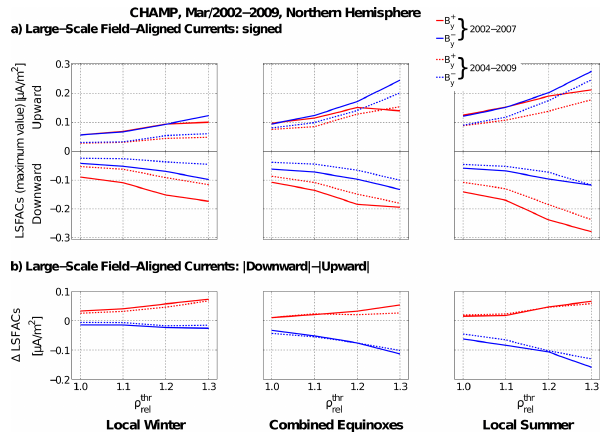
Fig. 9. The same as Fig. 8 but for (a) the peak amplitudes of up- ward and downward LSFACs and (b) the absolute difference be- tween peak amplitudes of downward and upward